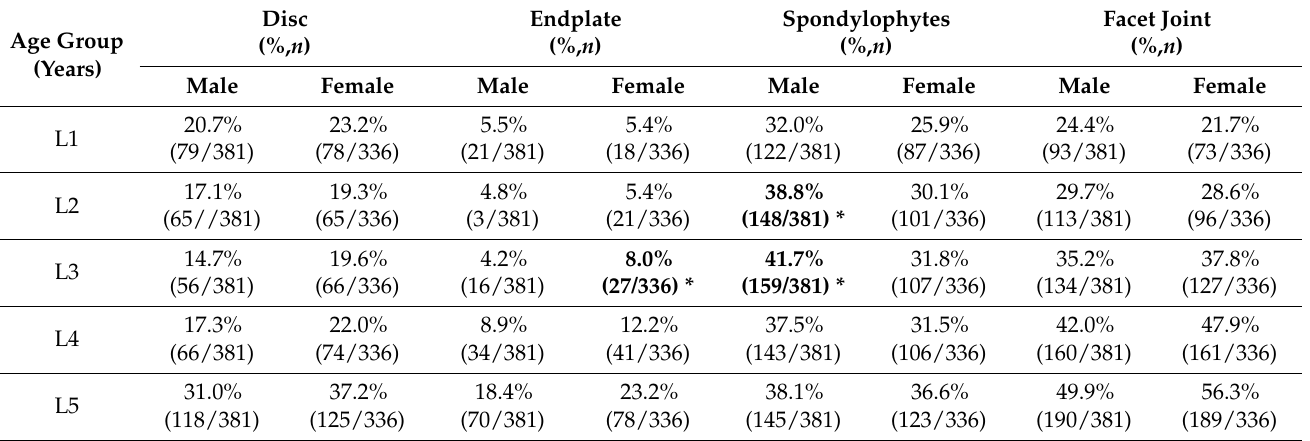
Table 3. Frequency of degenerative lesions per segment. Relative and absolute frequencies. Signifi- cantly higher frequencies compared to opposite sex are printed bold and marked with an asterisk (*); p -values were derived from Chi 2